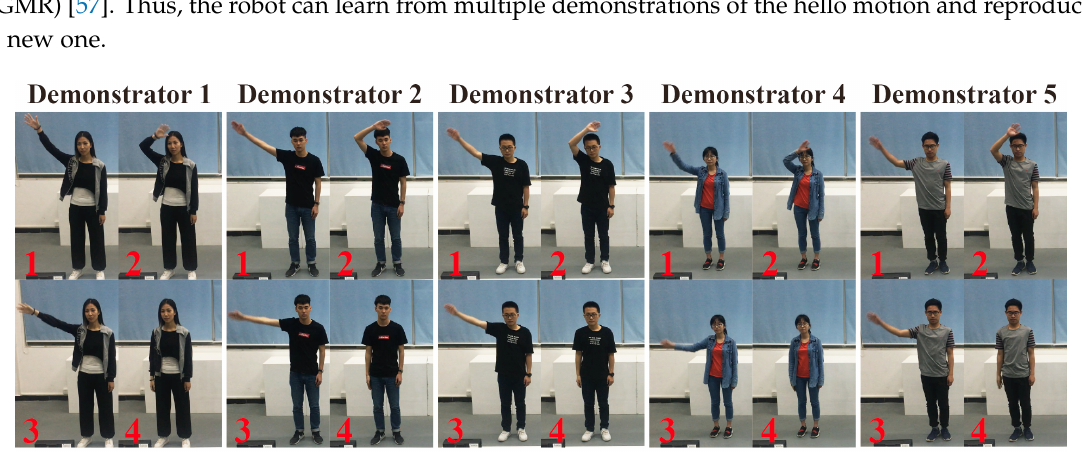
Figure 20. The snapshots of the hello motion performed by five